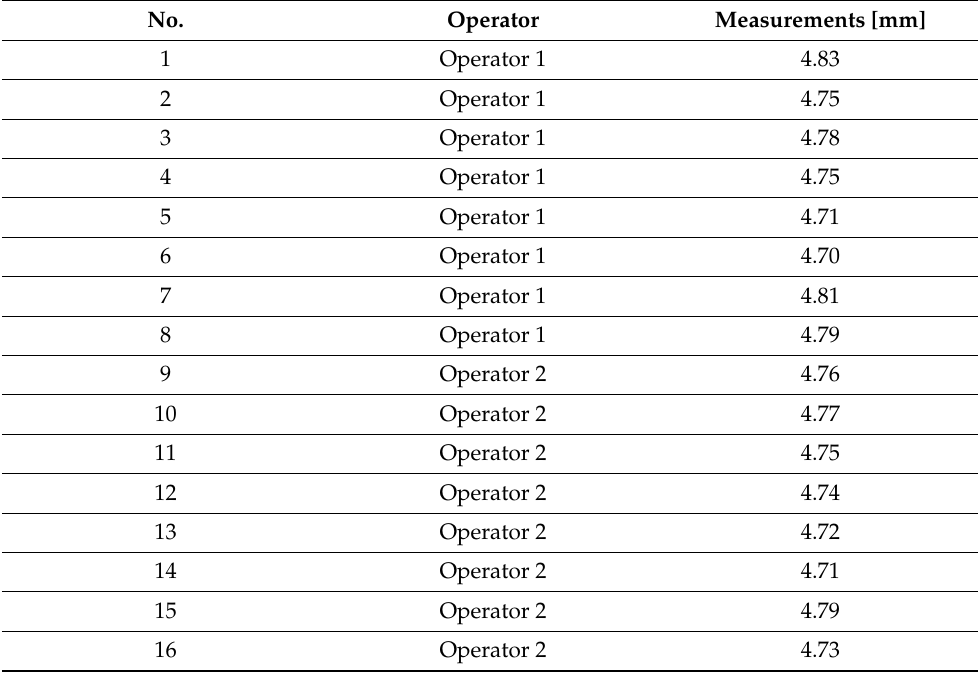
Table 4. Two operators’ collective measures.